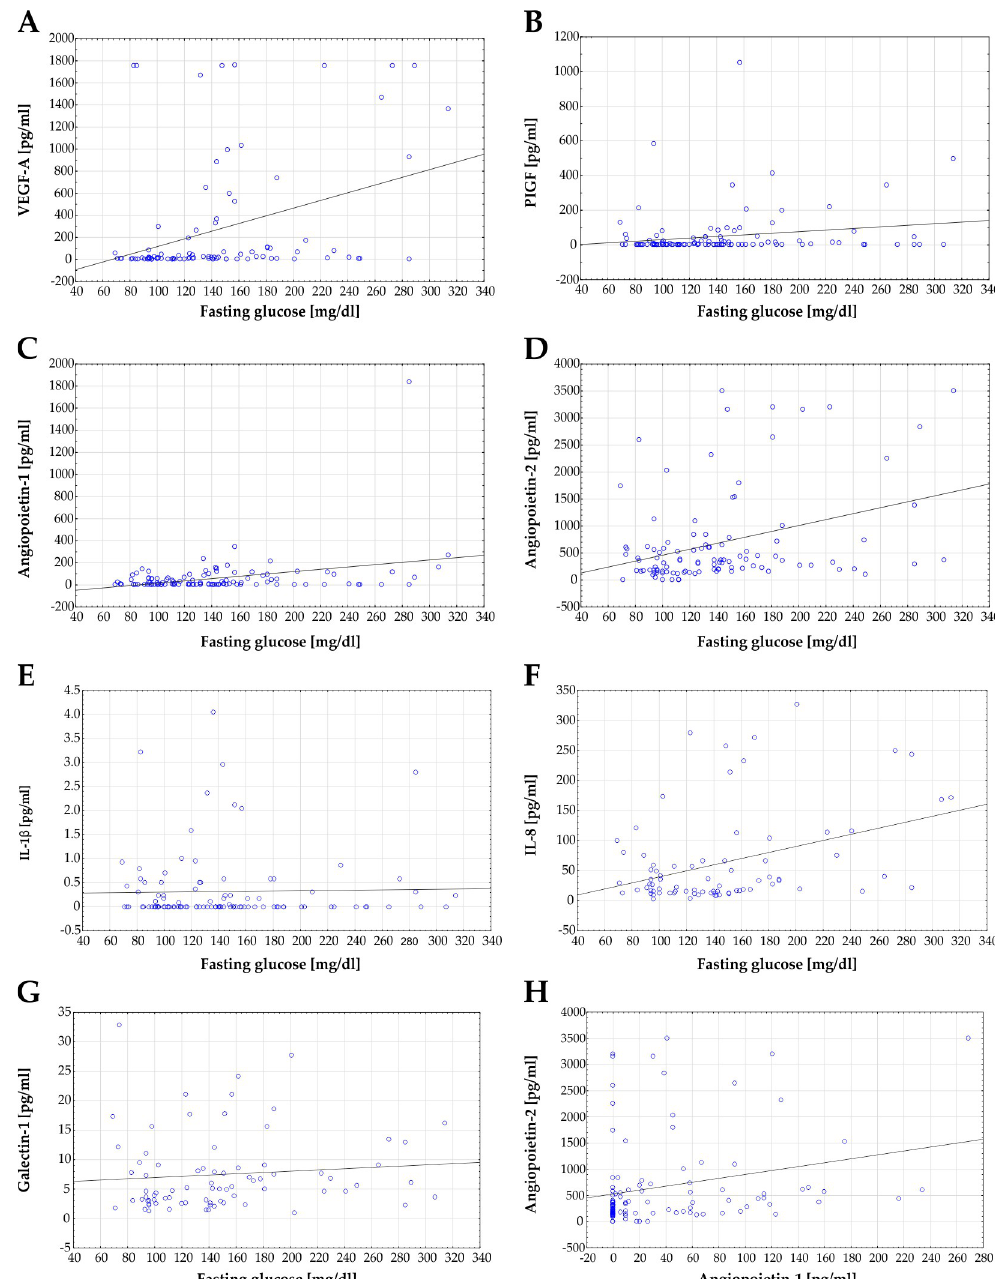
Fig 3. Correlation of protein concentration and fasting glucose level. A) Correlation analysis of VEGF-A concentration in vitreous humour and fasting glucose level revealed a significant correlation for all samples (r = 0.366; p < 0.001; r 2 = 0.134). B) Correlation analysis of PIGF concentration and fasting glucose also showed a significant correlation (r = 0.186; p = 0.046; r 2 = 0.035). C) Scatterplot of Angiopoietin-1 versus fasting glucose. A significant correlation between Angiopoietin-1 level and fasting glucose level could be observed (r = 0.3275; p < 0.001; r 2 = 0.076). D) Also, a significant correlation was found between Angiopoietin-2 and fasting glucose level (r = 0.348; p < 0.001; r 2 = 0.121). E) A correlation between levels of IL-1 β and fasting glucose could not be observed (r = 0.023; p = 0.813; r 2 = 0.001). F) In contrast, a significant correlation between IL-8 and fasting glucose level was detectable (r = 0.374; p < 0.001; r 2 = 0,140). G) Scatterplot of Galectin-1 levels and fasting glucose levels revealed no correlation (r = 0.099; p = 0.386; r 2 = 0.0098). H) A significant correlation between Angiopoietin-1 and Angiopoietin-2 levels were detectable, excluding one outlier patient (patient #52; r = 0.245; p = 0.011; r 2 = 0.060). Each blue dot represents one patient, linear regressions are displayed as solid grey lines.